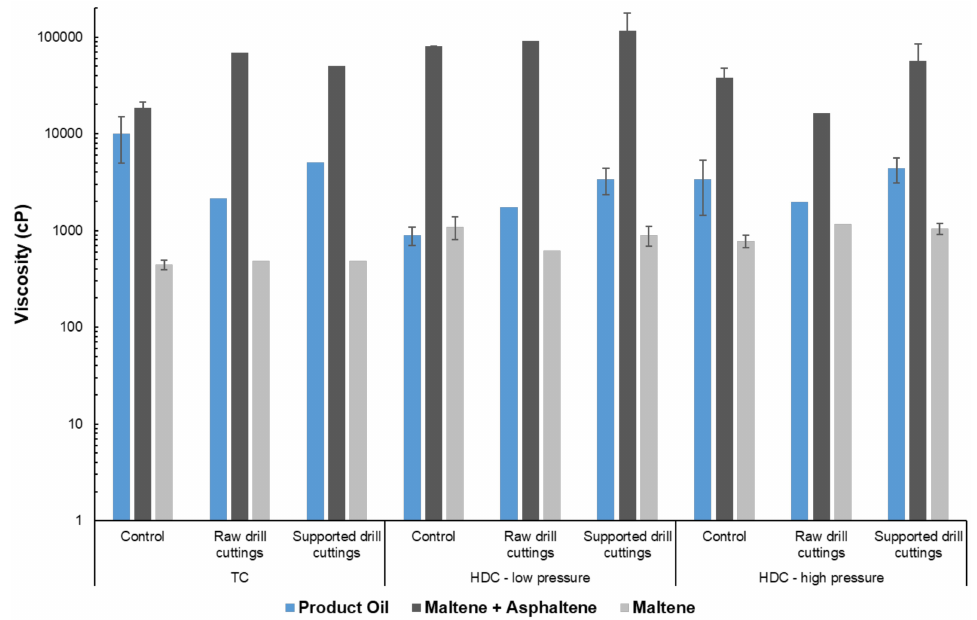
Figure 8. Results of viscosity measurement at 37 ◦ C of the product oil, maltene-asphaltene and maltene fractions. The pressure was 70 psi and 365 psi for low and high-pressure runs, respectively.